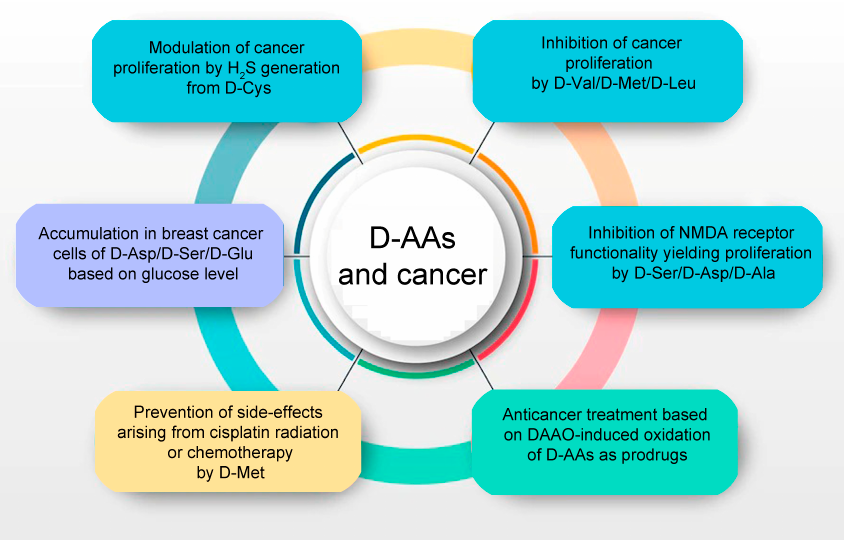
Figure 2. D-amino acids are related to cancer cell proliferation and metabolism (light blue and violet background, respectively), oxystress anticancer therapy (green background), and protection from side effects due to radiation or chemotherapy (orange background).